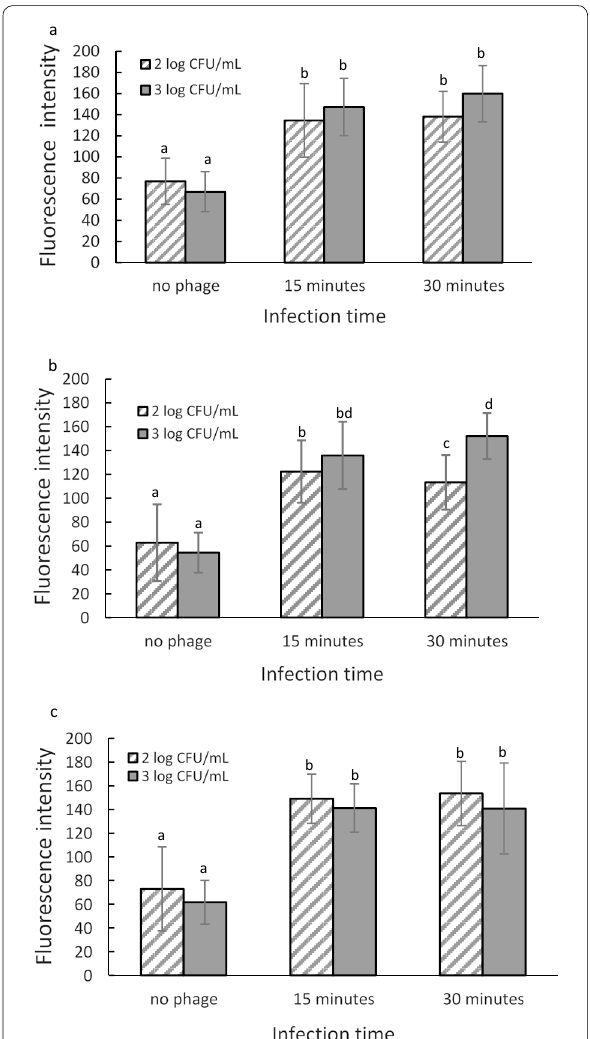
Fig. 6 Mean gray value of fluorescent images of E. coli BL21 10 2 CFU/ ml and 10 3 CFU/ml 4 h enrichment in TSB ( a ), coconut water ( b ), and apple juice ( c ) after 15- and 30-min infection with bacteriophage T7-ALP. Treatments with different letters are significantly different (P < 0.05). Error bars indicate standard deviation of ±